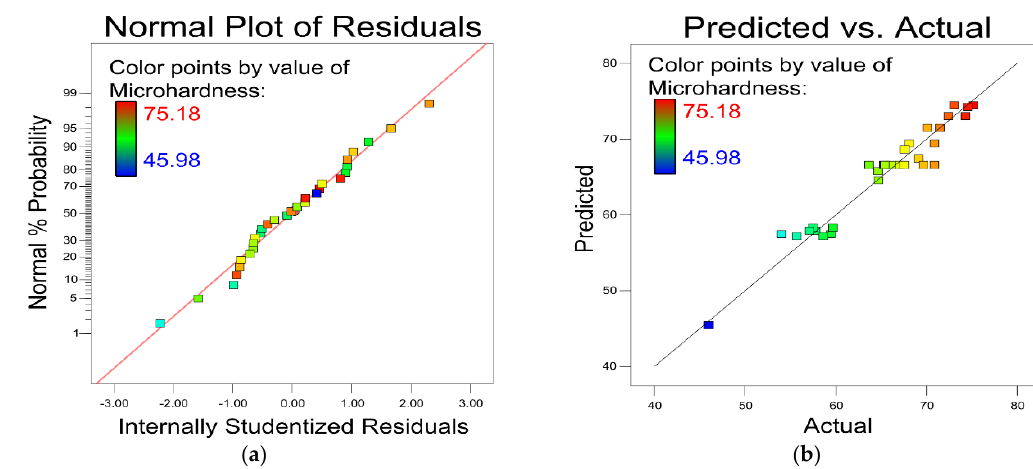
Figure 3. ( a ) Residual analysis of micro-hardness. ( b ) Comparison of predicted and actual micro-hardness.